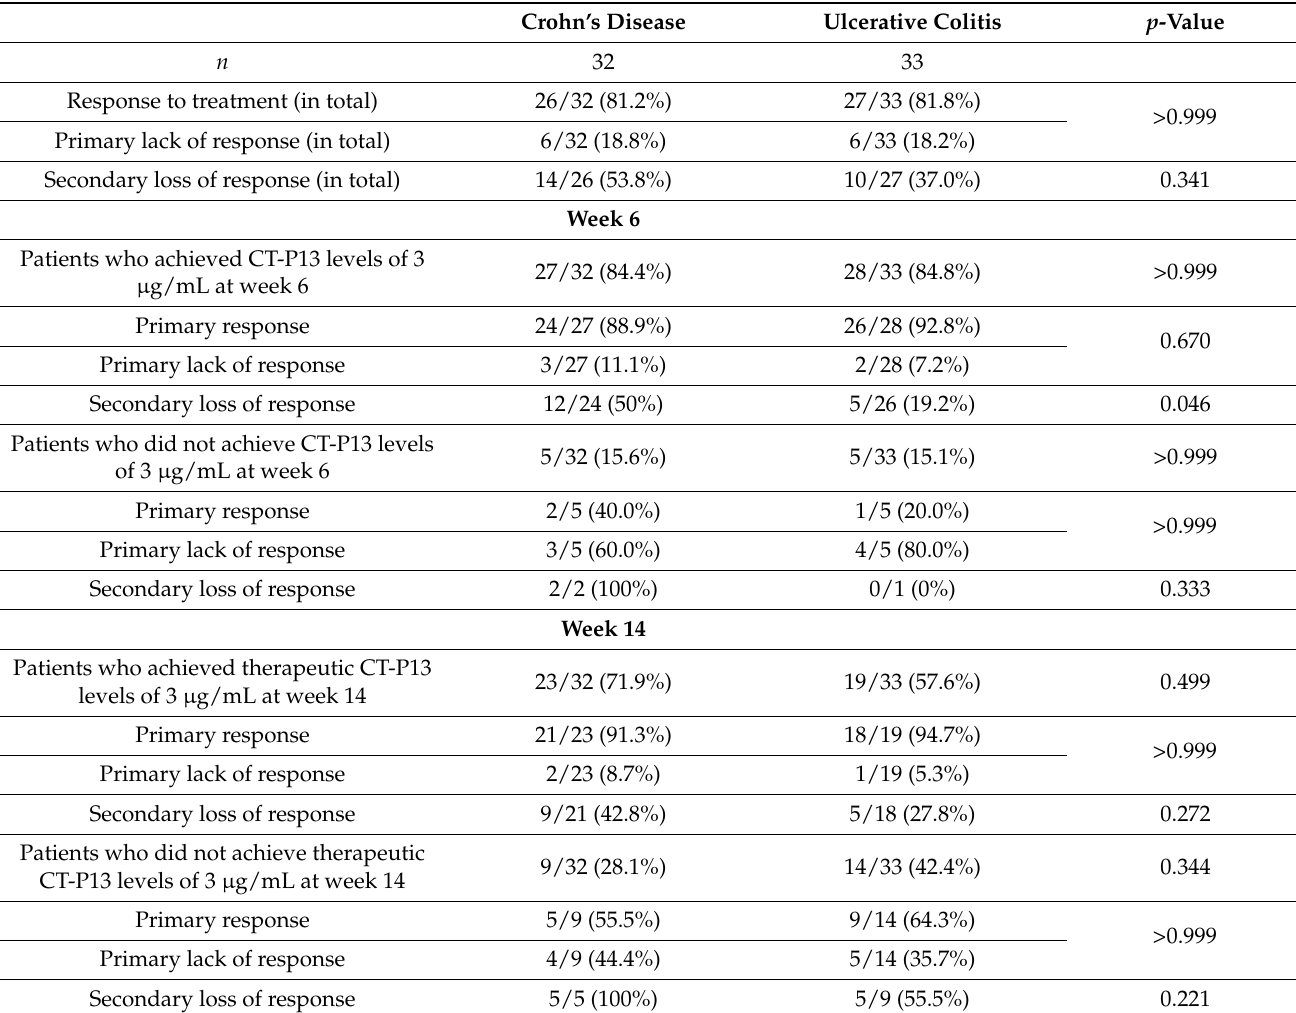
Table 3. Comparison of treatment response in both groups according to CT-P13 levels at weeks 6 and